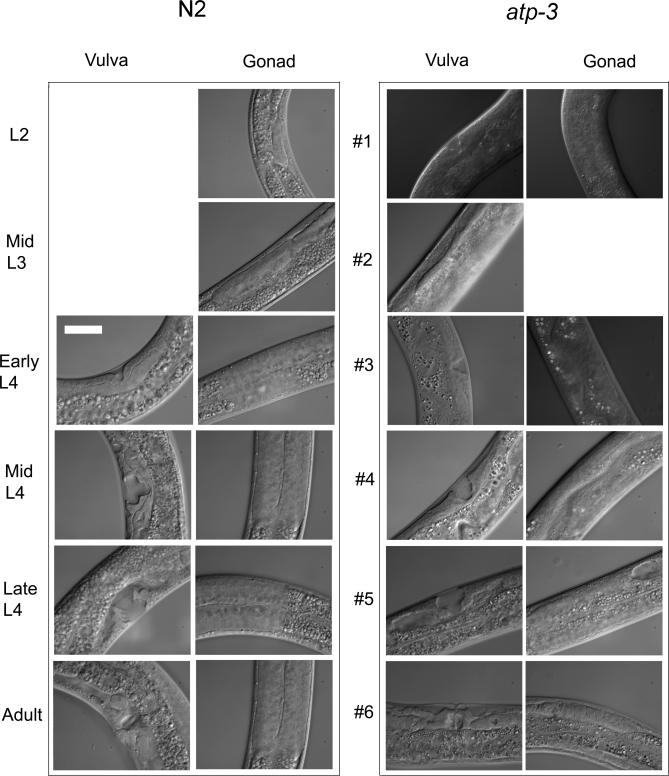
Rate of Larval Development Decreases with Increasing atp-3 RNAi ConcentrationN2 animals exposed to undiluted atp-3 RNAi (right panels) from the time of hatching were collected for Normaski imaging (1000×), 4 d later (worm #1) and 6 d later (worms #2–6) . Shown is the extent of vulval and gonadal development in selected individuals. For comparative purposes, N2 animals (left panels) were cultured on control bacteria and collected during various stages of their development. Scale bar applies to all panels, and indicates 25 μm.